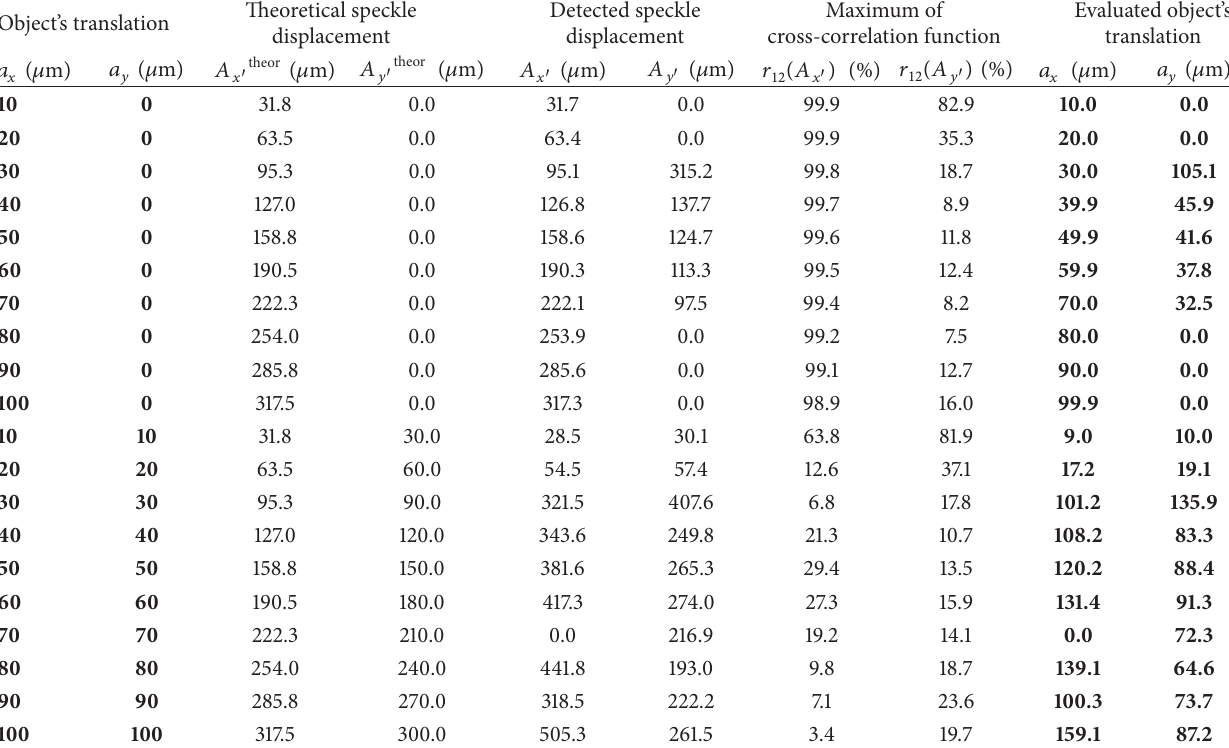
Table 2: Object’s translation components 𝑎 𝑥 and 𝑎 𝑦 computed from acquired positions 𝐴 𝑥 󸀠 and 𝐴 𝑦 󸀠 of the maxima 𝑟 12 (𝐴 𝑥 󸀠 ) and 𝑟 12 (𝐴 𝑦 󸀠 ) of normalized cross-correlation function 𝑟 12 of intensities 𝐼 1 and 𝐼 2 by means of (4) and (5). Initial parameters of the computer simulation are according to Figure 1: 𝑉 𝑥 = 𝑉 𝑦 = 4 mm, 𝑉 𝑥 󸀠 = 𝑉 𝑦 󸀠 = 8 mm, 𝑚 𝑖 = 𝑛 𝑖 = 400 , 𝑚 = 𝑛 = 570 , 𝐿 𝑜 = 0.4 m, 𝐿 𝑠 = 0.2 m, 𝜃 𝑜 = 30 ∘ , 𝜔 𝑜 = 60𝜇 m, and 𝜆 = 632.8 nm. Mean speckle size of detected speckle pattern oriented along 𝑥 󸀠 - and 𝑦 󸀠 - axes direction is 𝛼 For the sake of clarity, the values of object’s translation components (columns 1 and 2) and corresponding evaluated values (columns 9 and 10) are highlighted by bold